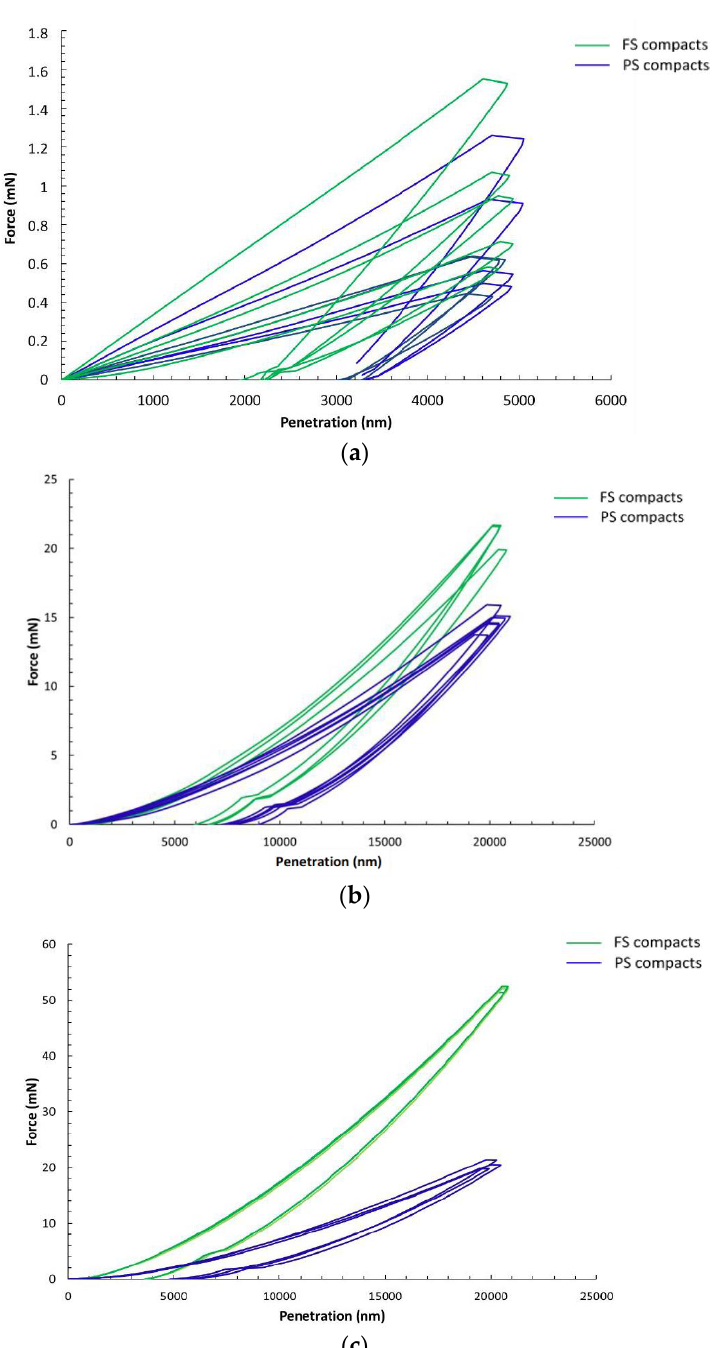
Figure 1. Load – deflection curves in spherical indentation on fumed silica (FS, in green) and Figure 1. Load–deflection curves in spherical indentation on fumed silica (FS, in green) and precipitated precipitated silica (PS, in blue) compacts. ( a ) Berkovich tip; ( b ) 600-µm diameter sphere; and ( c ) 2000- silica (PS, in blue) compacts. ( a ) Berkovich tip; ( b ) 600- µ m diameter sphere; and ( c ) 2000- µ m µm diameter sphere . diameter